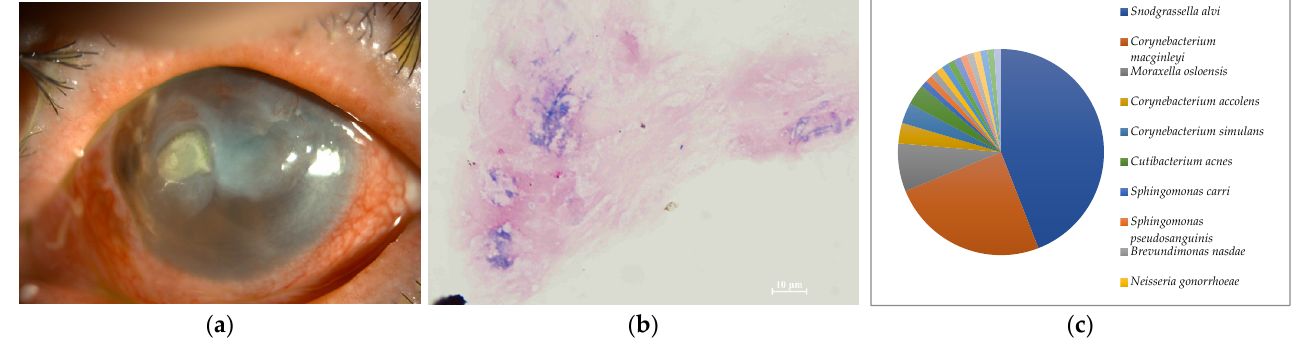
Figure 5. ( a ) Anterior segment photograph. The entire corneal graft was opaque, with abscess and infiltration, and temporal corneal graft showed melting. ( b ) Smear microscopy. Diplococci that ap- pear Gram-negative were determined primarily due to heterogeneous staining but were found to be encapsulated Gram-positive. ( c ) Nanopore sequencing results (relative abundance) of Case 5. An overwhelming majority of Streptococcus pneumoniae was detected by MinION.